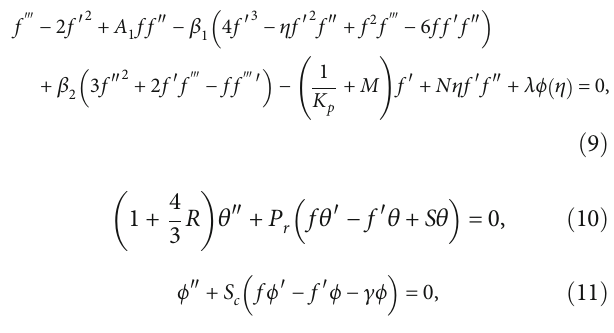
on the velocity pro fi le. (b) Di ff erent values of permeability K p on the concentration pro fi p